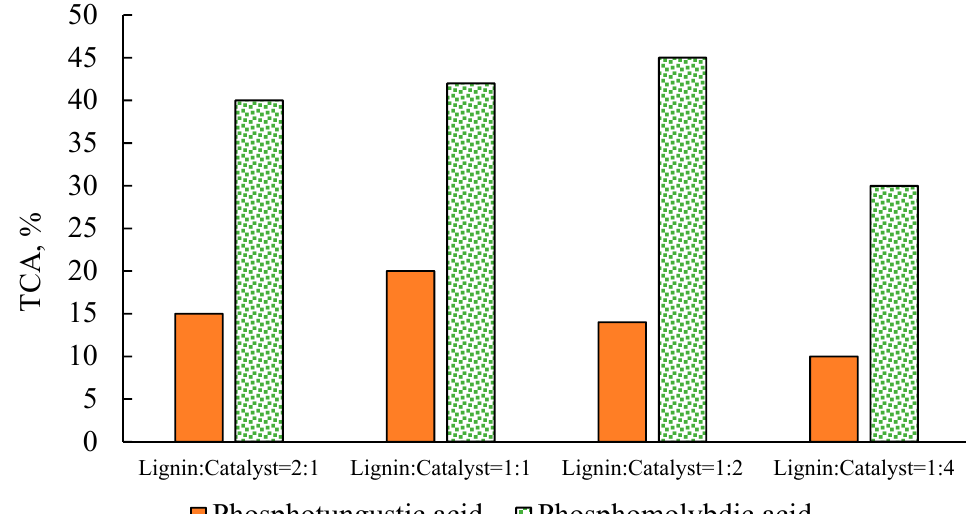
Figure 4. Effect of the lignin to catalyst ratio ( w : w ) on the total yield of carboxylic acids at 200 °C with a 60-min reaction time.